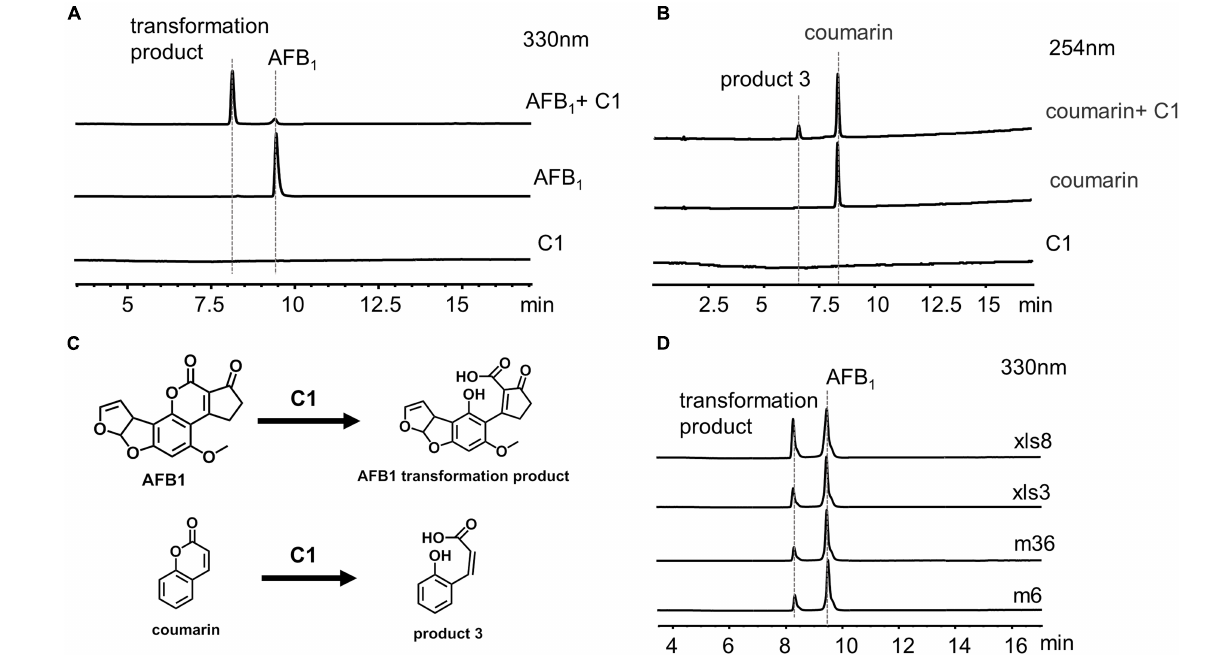
FIGURE 7 | C1 reaction with aflatoxin B 1 (AFB 1 ) and coumarin. (A) HPLC analysis of the reaction between C1 and AFB 1 . (B) HPLC analysis of the reaction between C1 and coumarin. (C) Speculative reaction mechanism of C1. (D) AFB1 was transformed by C1 from different strains. AFB 1 was transformed by C1 from four different strains into the same transformation product as m29. HPLC, high-performance liquid